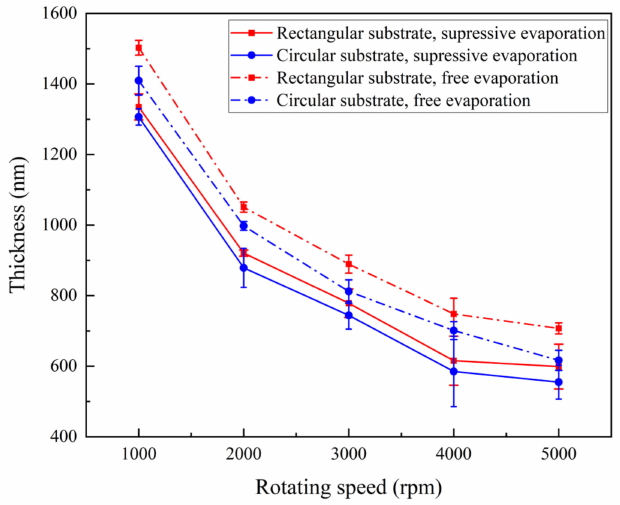
Figure 6. Comparison between solvent evaporation experiment and original experiment